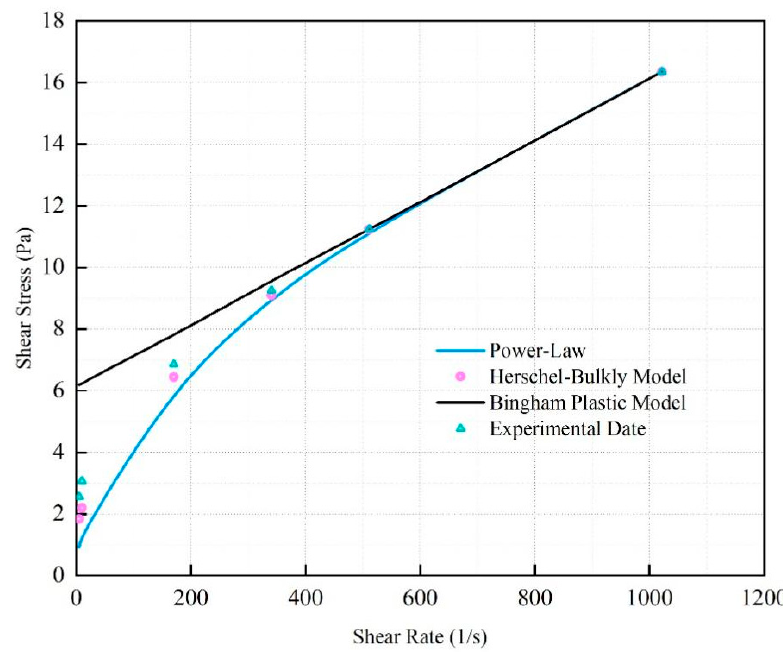
Figure 7. Rheological model of shear rate and shear strength of the SUV–Bent gel system.